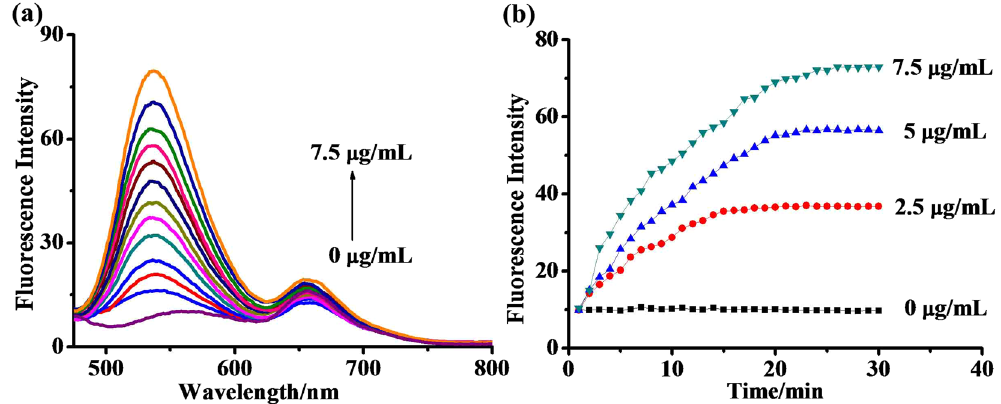
Figure 2. ( a ) Fluorescence responses of probe (1) (1.0 × 10 − 5 M) to different concentrations of nitroreductase (NTR) in PBS buffer with 1% DMSO and 10 μ M NADH. ( b ) A plot showing the fluorescence intensityof probe (1) (1.0 × 10 − 5 M) at 537 nm vs. the reaction time in the presence of different concentration of NTR: 0 (control), 2.5, 5, and 7.5 µ g/mL. Measurements were performed in 10 mM PBS buffer at 37 °C (pH =